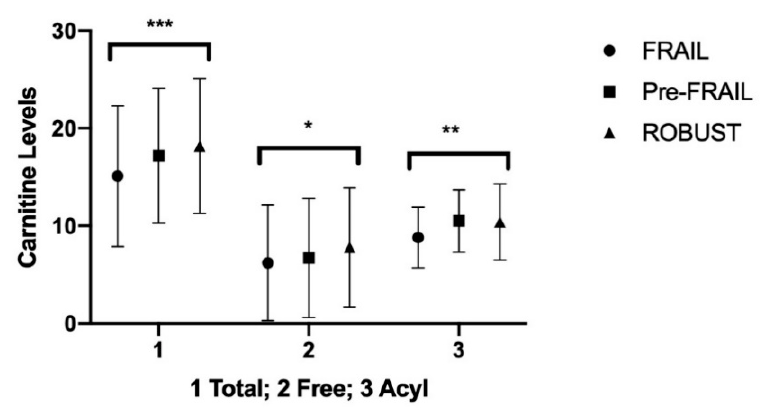
Figure 2. Carnitine in urine; Summary p value: * p < 0.05; ** p < 0.005; *** p < 0.001